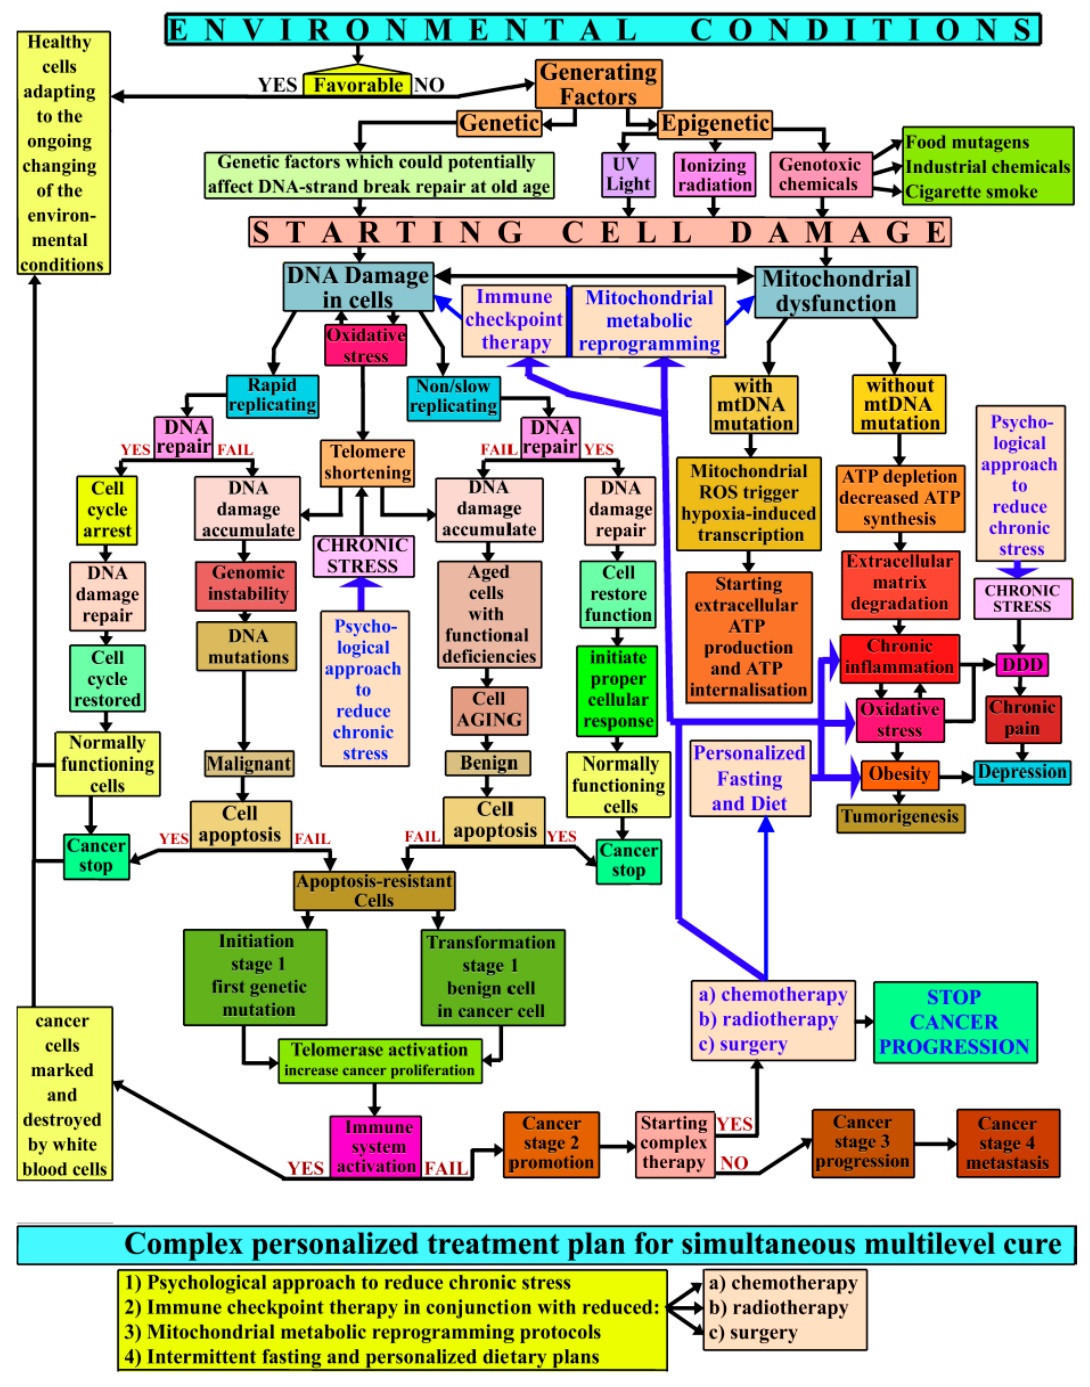
Figure 1. Cancer’s complex mechanism chart.